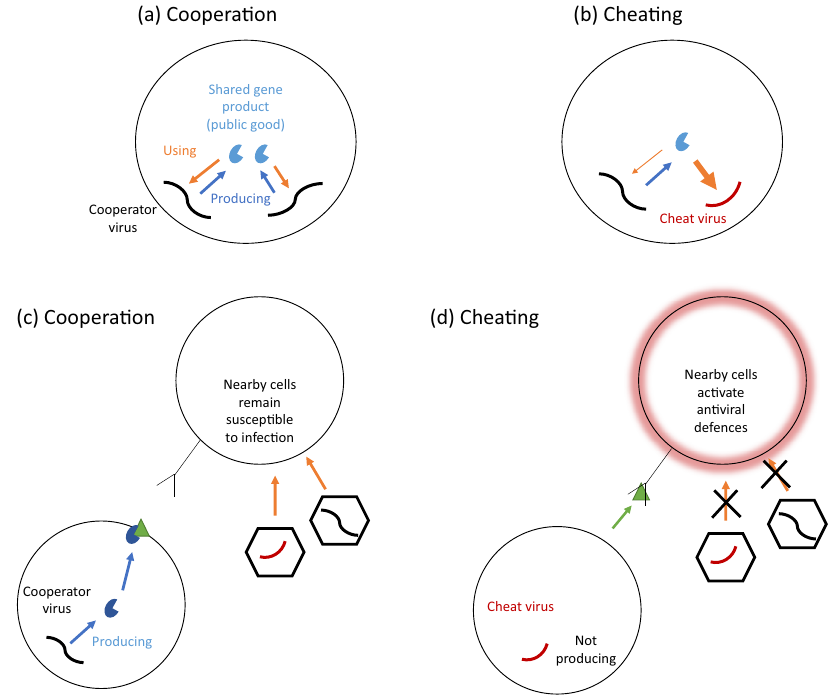
Fig. 2 Viruses can cooperate when infecting the same cell, and also when infecting different cells. a In coinfection, shared viral gene products, such as replicase enzymes or capsid proteins, have the potential to bene fi t other viral genomes, and hence act as cooperative ‘ public goods ’ (Box 2). b When multiple viral genomes infect a host cell, there is also the potential for cheating, where some individuals bene fi t from the public good without producing it (cheats). c Cooperation can also occur between viral genomes that infect different host cells. Here, cooperative viruses produce a gene product that prevents host cells releasing interferon, keeping the local population of host cells susceptible to infection, and hence providing a bene fi t to other viral genomes infecting different cells 5 . d Cheat viruses do not block interferon, and hence replicate faster than cooperators. This cheating is costly for the viral population as a whole, because interferon is released from the infected cell, binding to nearby cells, which become resistant to infection by other viral